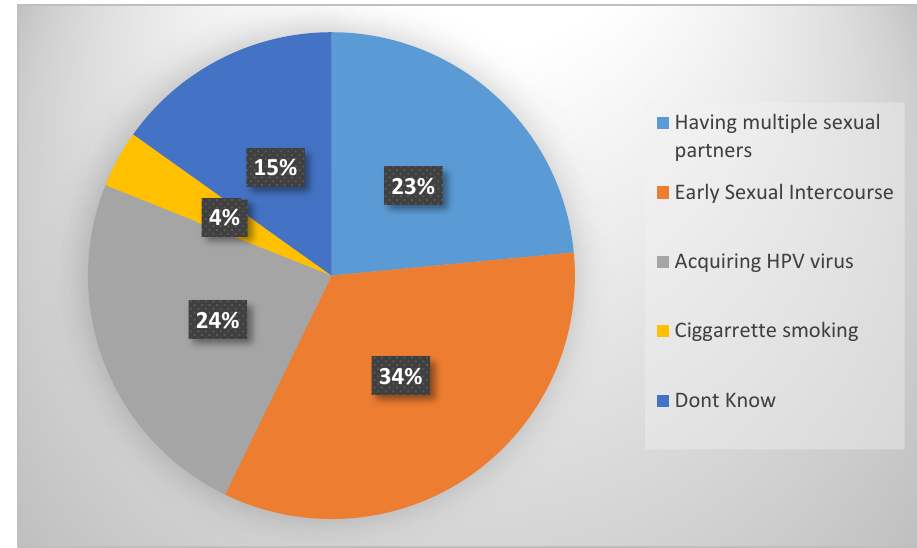
Figure 1. Risk factors of cervical cancer.